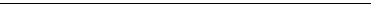
time evolved thermo(cid:12)eld double state. The holomorphic component of the Chern-Simons connection a retains the form displayed in eq. (4.2), and the expression for the holomor- + phic Wilson line in terms of the eigenvalues of a is given by eq. (D.4). The values of +